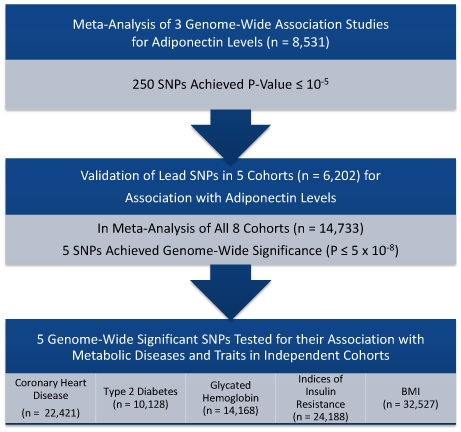
Overall study design.